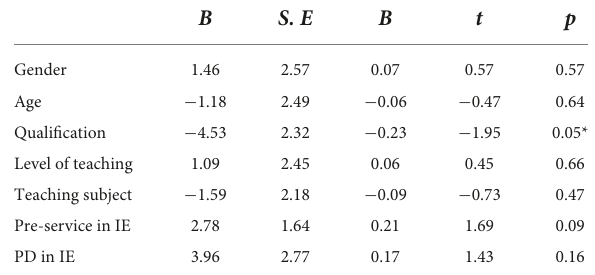
TABLE 3 Summary of demographics regressed on